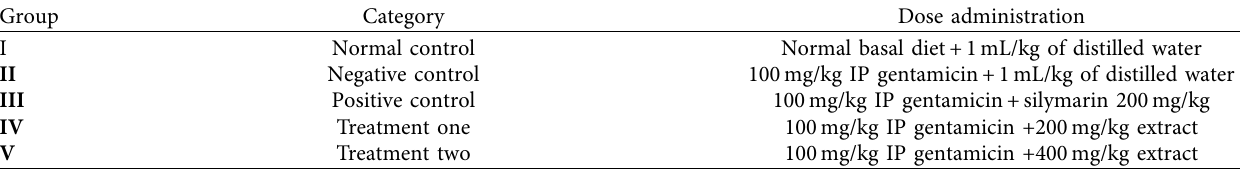
Table 1: Experimental animals grouping and treatment protocol for a period of 15 th day.